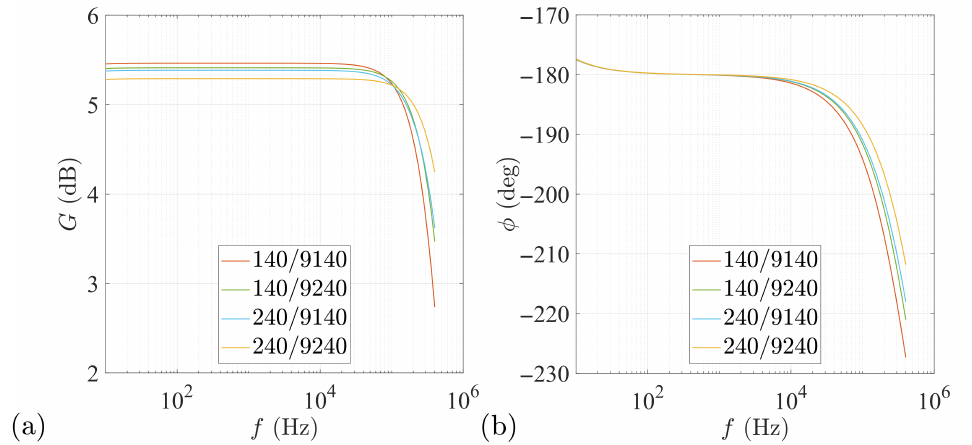
Figure 7. Numerically simulated: ( a ) amplitude; and ( b ) phase characteristic of the LF amplifier (without the pre-processing stage).